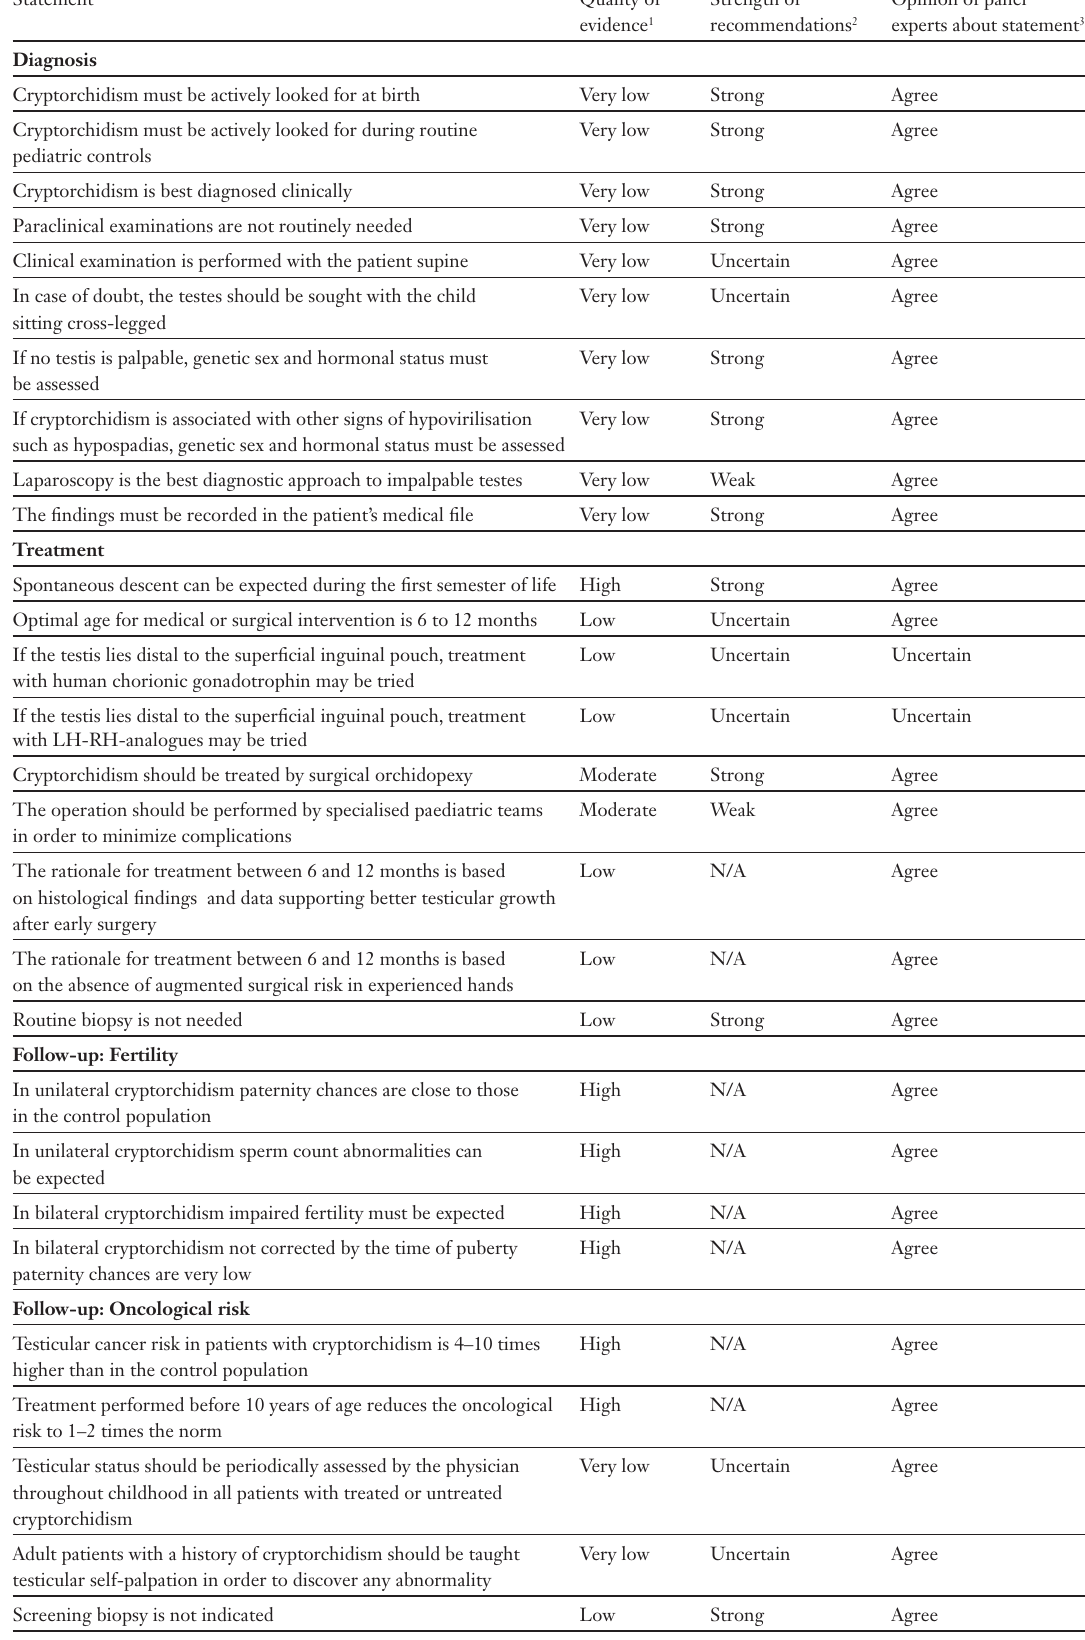
Summary of statements for the diagnosis and clinical management of cryptorchidism: quality of evidence, opinion of panel experts and strength of recommendations, where